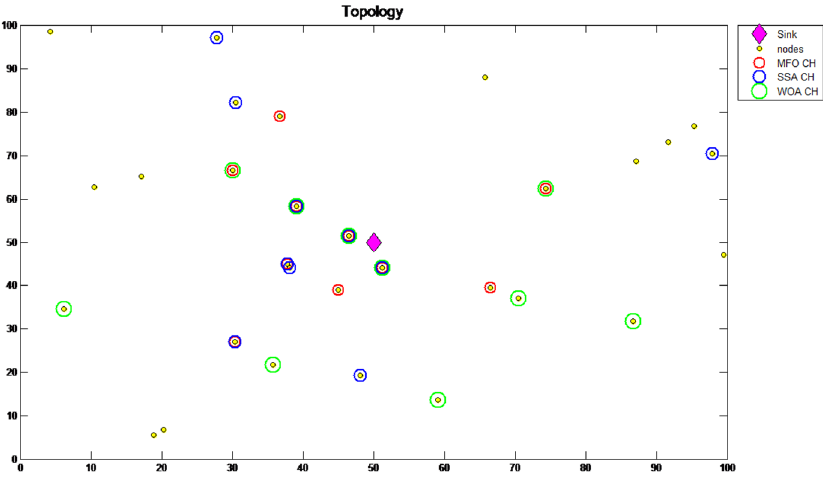
Figure 1. Cluster head selection in WSN via WOA, MFO and SSA. Table 2. Simulation parameters of the